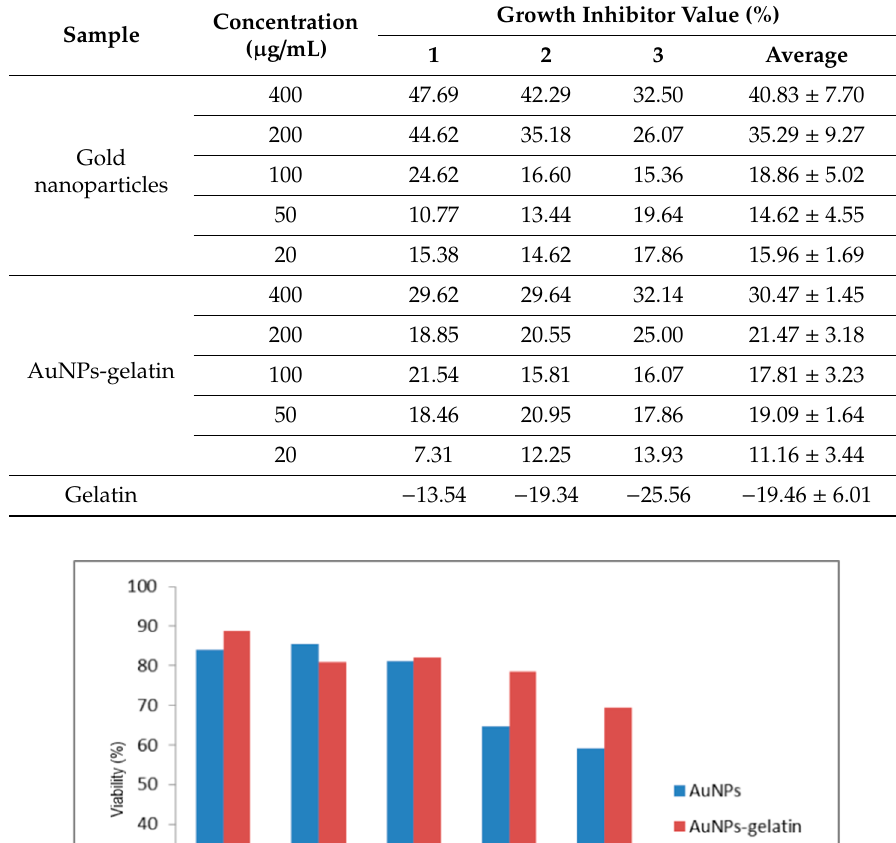
Table 5. Growth inhibitor value of fibroblast cells incubated with AuNPs and AuNPs-gelatin.